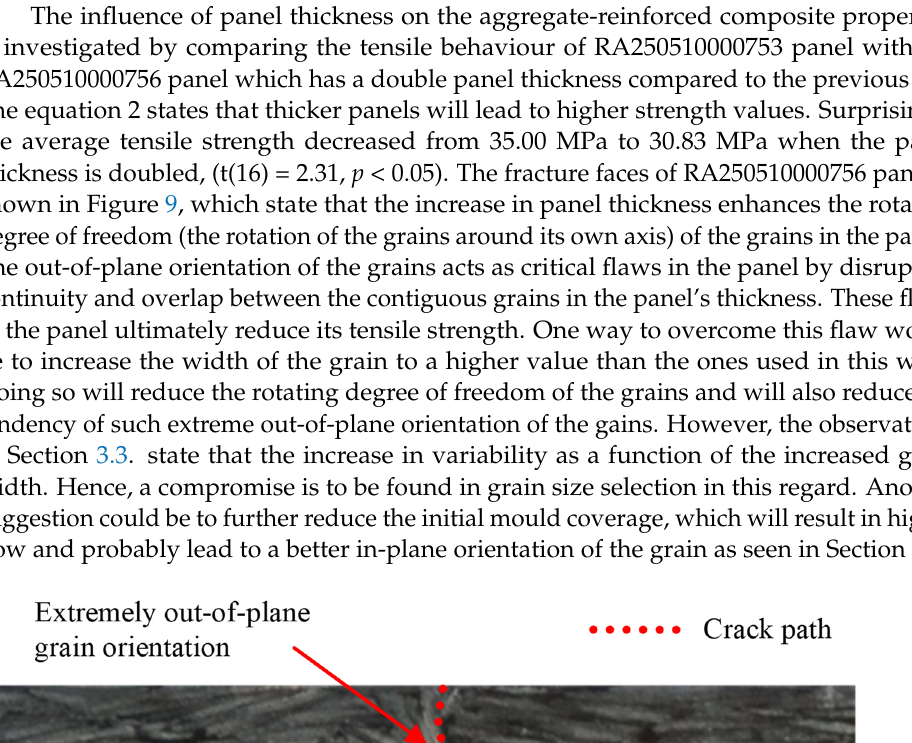
strength and not in modulus. 3.7. Overall Assessment The average tensile strength and modulus of all composite samples are reported in Figure 10a and Figure 10b, respectively. It is observed that the tensile moduli of the ag- gregate-reinforced composites are comparable to one of the continuous QI panels with a decrease in the order of 12%. A good proportion of the tensile modulus can therefore be maintained using this recycling/reprocessing method. On the other hand, from the tensile strength point of view, significantly lower values are measured for the aggregate-rein- forced composite panels compared to the QI panel as shown in 10a. The configuration of the aggregate-reinforced composite which gave the highest tensile strength, is the RA250502500753 panel with a strength of 60.66 MPa which represents a decrease of − 67% compared to the continuous QI panel strength of 185.49 MPa. Such a significant difference in tensile strength can be attributed to the discontinuous nature of the grain within the recycled composites. This probably generates stress concentrations around the edges of the grains and resin-rich regions at the grain’s tip. Both phenomena contribute to the re- duction of the tensile strength [44,45]. Furthermore, the important loss in tensile strength can also be attributed to the fact that the failure of the aggregate-reinforced composites is dominated by the matrix as no fibre failure was observed in the fracture faces as noticed in Section 3.1. However, the strength values of the aggregate-reinforced composites re- main higher than the strength of neat unreinforced PP, 25 MPa and show potential suita- bility for stiffness driven and non-critical applications. Future works to improve the strength should however be carried out by studying into more depth the failure mecha- nisms. Exploring other grain shapes (predefined or random) may also be considered.